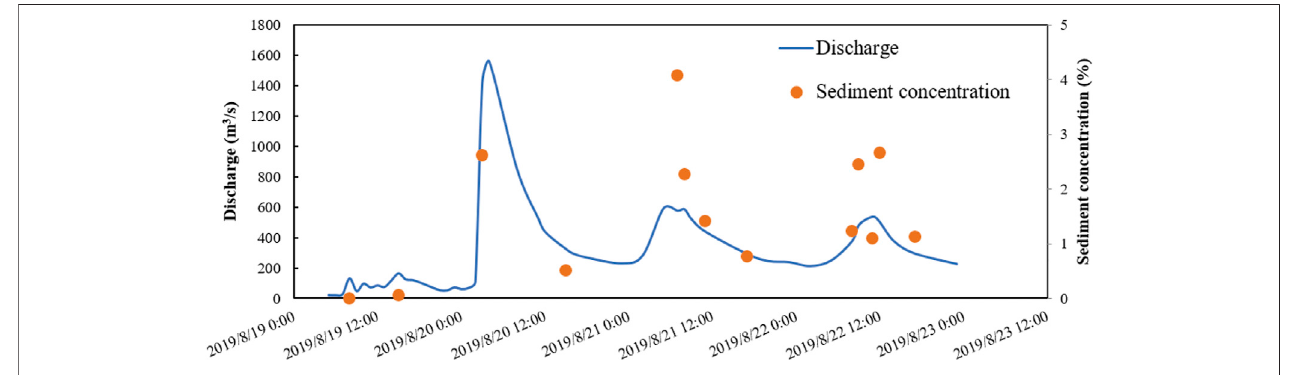
FIGURE 8 | Measured sediment concentration changing along fl ash fl ood